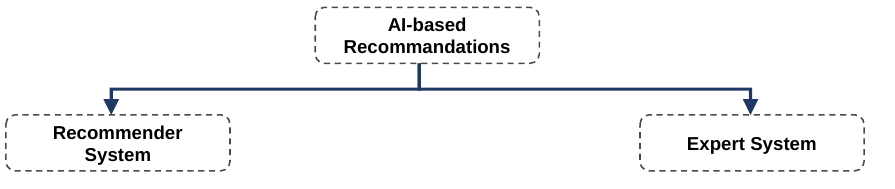
Figure 2. Taxonomy of AI-based Recommendations [9].